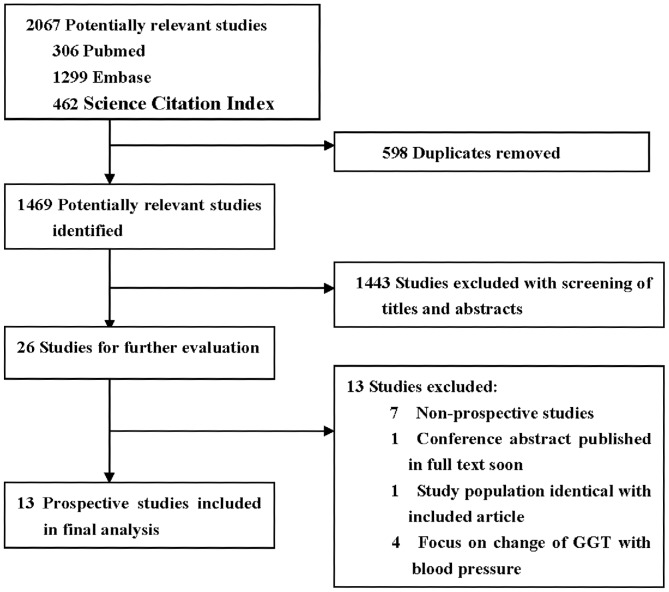
Flow diagram of included studies of meta-analysis.